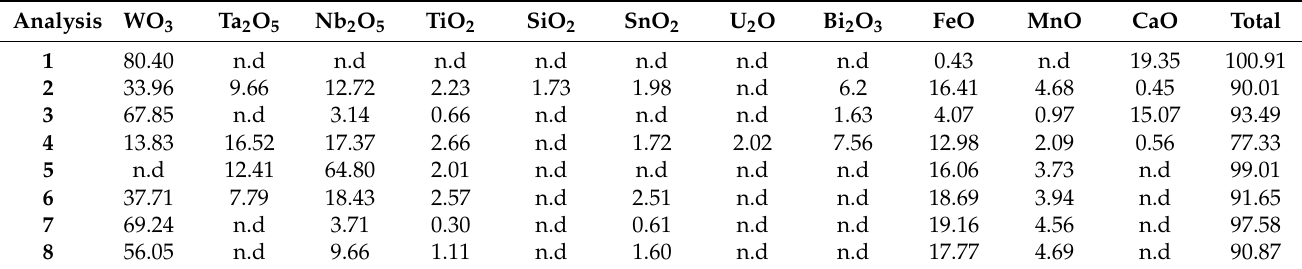
Figure 7. ( a , b ) SEM/EDS-BSE images showing position of Nb-Ta-rich phases belonging most likely to columbite family and their association with scheelite grains. Numbered crosses depict position of point chemical analyses (see Table 4). Table 4. Chemical composition of Nb-Ta-rich phases as determined by SEM/EDS (for position, see Figure 6). Analysis WO